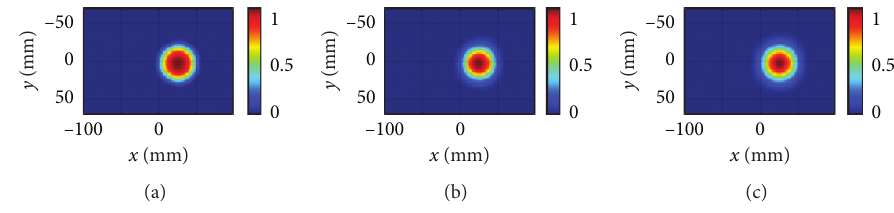
Figure 12: The imaging results of the single